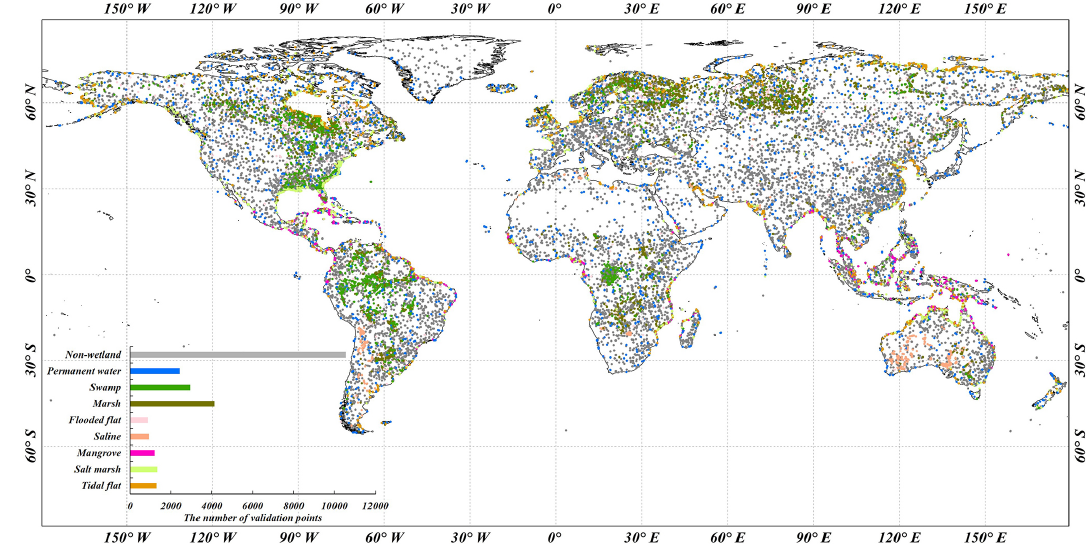
Figure 6. The spatial distribution of 25709 global wetland validation samples using the stratified sampling strategy.